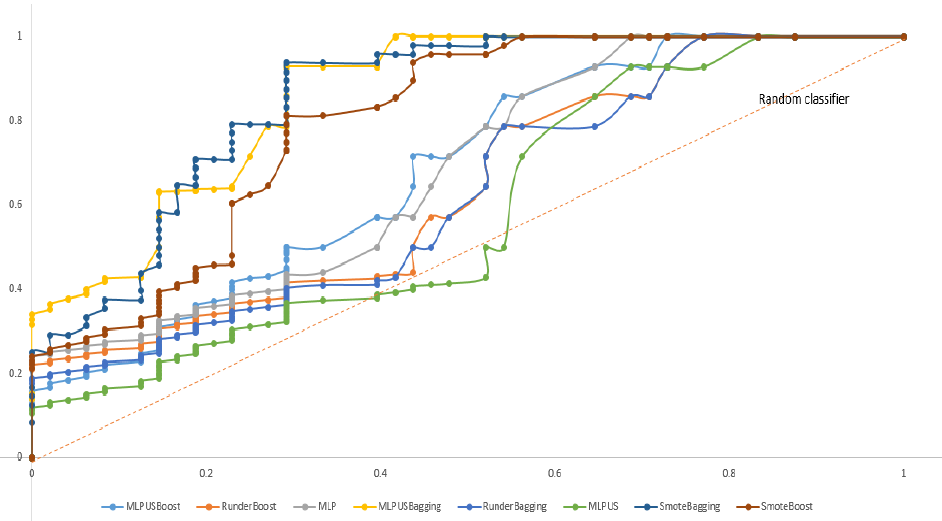
Figure 2. ROC curves result on Niger_Rice dataset for different methods.